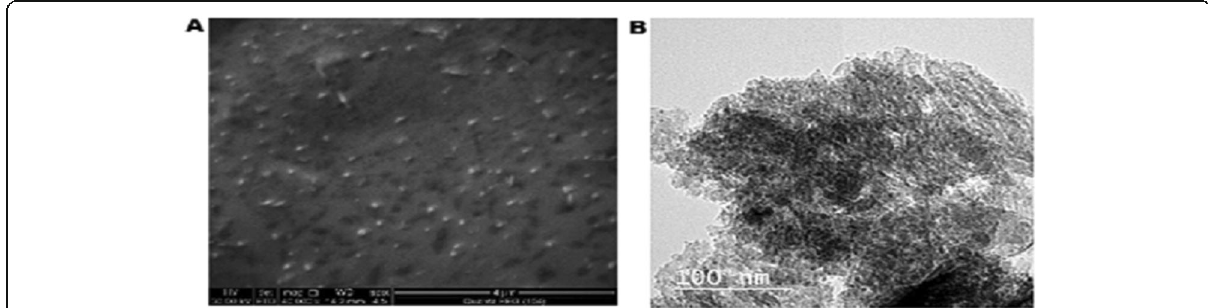
Fig. 2 Microstructure of silver-polyaldehyde-BSEPS composite prepared by microwave technique. ( a ) SEM, implies a homogeneous structure made up of edgy to spot-like, highlighted crystals of nanosilver with a uniform distribution and particle size range of 50 – 100 nm; ( b ) TEM, where the nanosilver particles are showing minute and even distributed black spots of Ag scattered all over the biocomposite of a more lighted colored matrix of the polyaldehyde-BSEPS nanoparticle